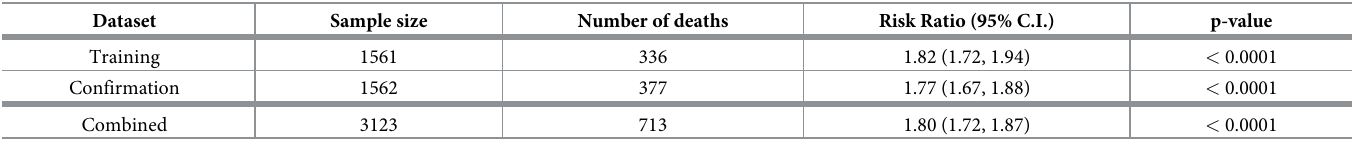
Table 3. Cox risk ratios for 1 unit increase in risk score.